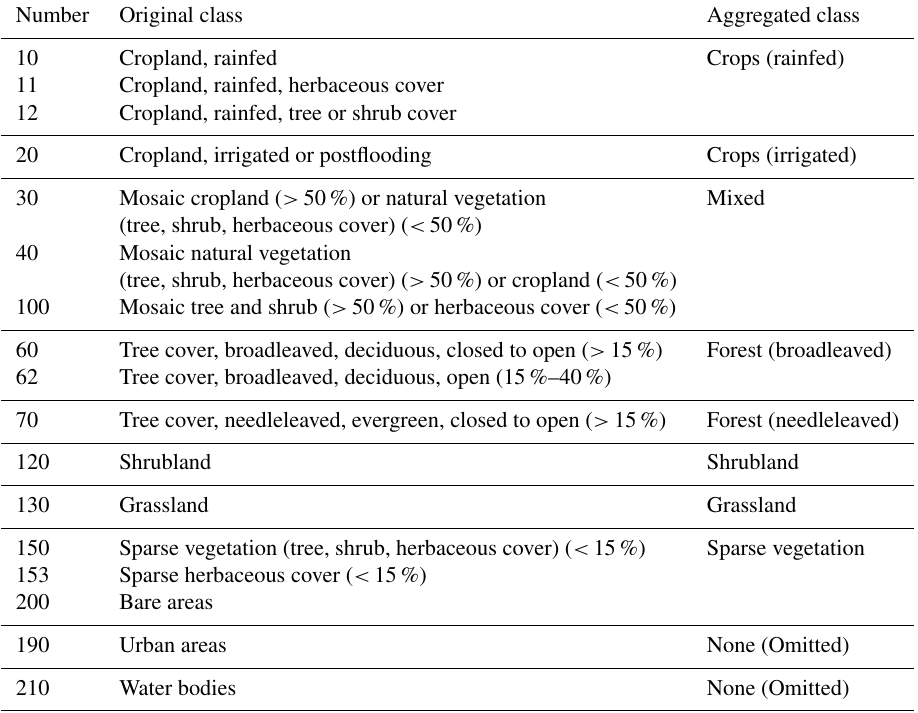
Table B1. Overview of the aggregation of land cover classes.